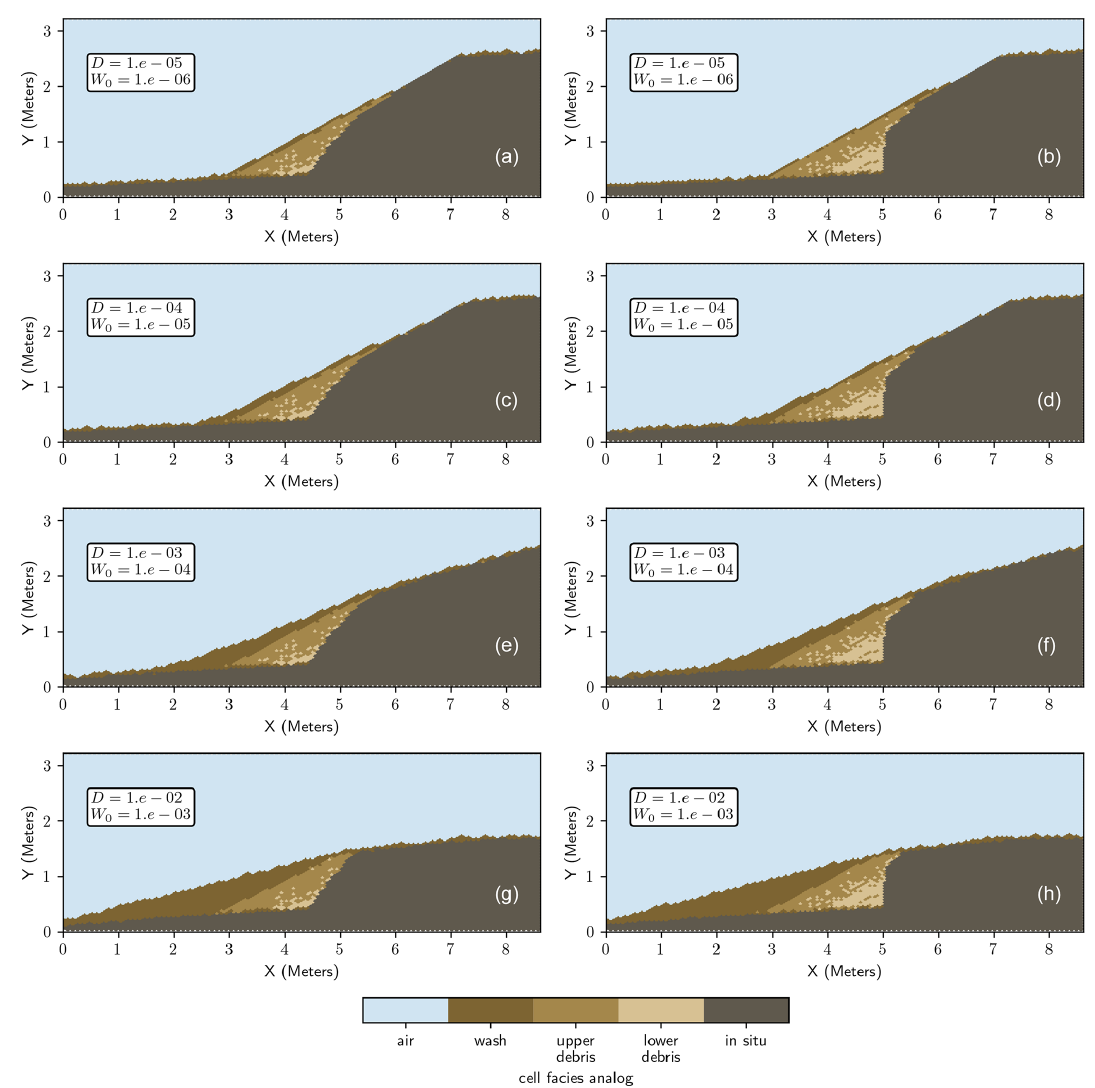
Figure 9. Example illustration of modeled colluvial wedges and facies analogs for 60 and 90 ◦ faults per varied geomorphic process rates with a fixed lateral collapse rate of 10 − 5 g (see Fig. 3: D : disturbance rate, W 0 : mobile regolith production rate). Order of magnitude changes in the geomorphic process rates result in different wedge forms and